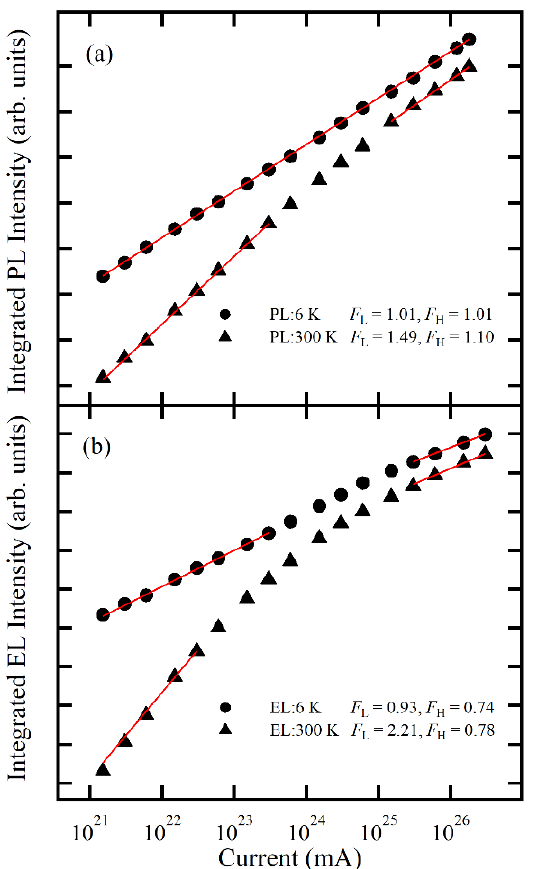
Figure 5. Dependence of the integrated PL-405 ( a ) and EL ( b ) intensity on the generation rate at 6 and 300 K. We also indicated the values of F in Equation (1) in the low and high current ranges labelled as F L and F H , respectively.